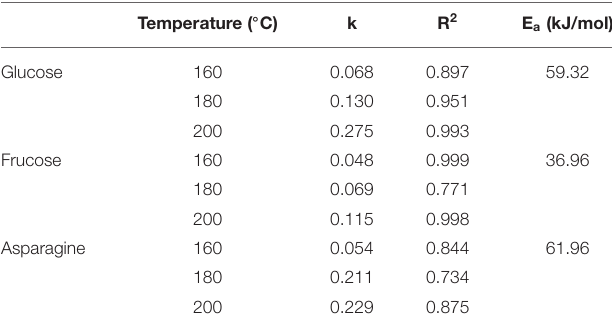
TABLE 1 | Parameter of kinetics of glucose, fructose, and asparagine in heated model system. Temperature ( ◦